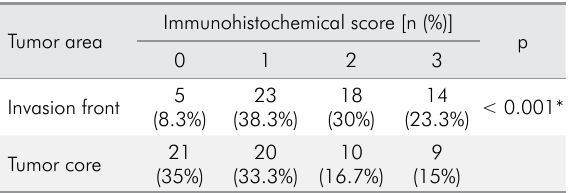
Table 1. Immunohistochemical scores of uPA according to the tumor area.